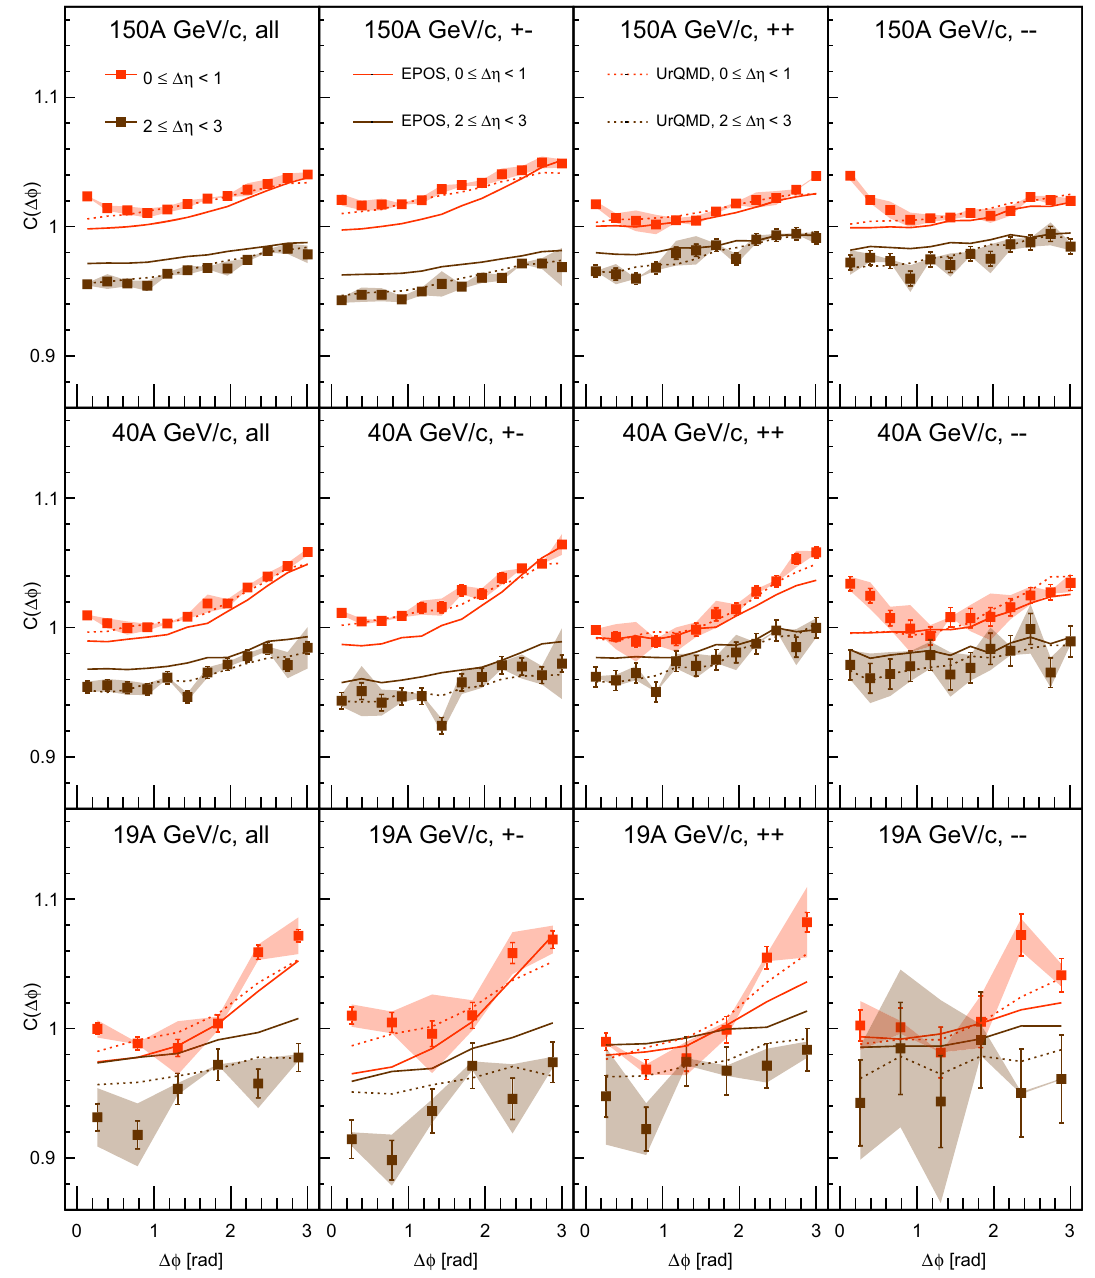
Fig. 17 Two-particle correlation function C ((cid:2)φ) obtained from pro- jectionof C ((cid:2)η,(cid:2)φ) ontothe (cid:2)φ axisforsubrangesof (cid:2)η .Fromleftto right the columns show respectively: all charge pairs, unlike-sign pairs, positive charge pairs, and negative charge pairs. Vertical bars denote